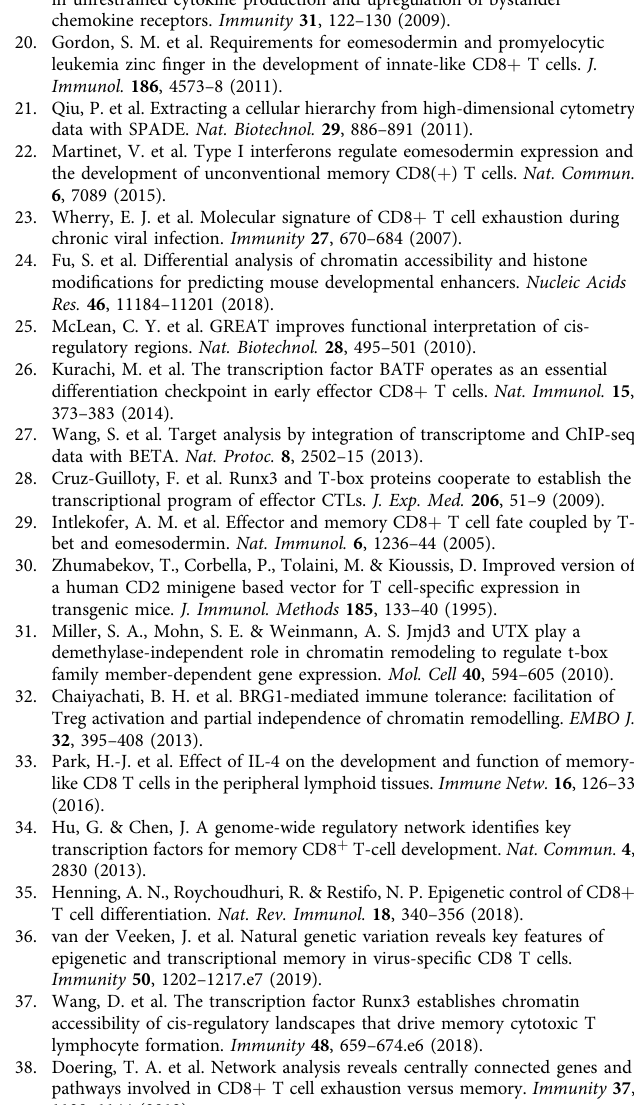
Fig. 7 BRG1 is critical to induce EOMES-dependent program. a Immunoblot (IB) of lysates from 293 cells transfected with an Eomes vector and immunoprecipitated (IP) with an anti-EOMES (up) or anti-BRG1 (down) antibody. b ChIP experiment for EOMES and BRG1 from WT and Eomes Tg CD3 + CD8SP thymocytes followed by qPCR at the indicated loci. Each horizontal bar represents an individual data point from a single experiment. c Representative fl ow cytometry plots gated on CD3 + CD8SP thymocytes from mice lacking Smarca4 expression in T cells ( Smarca4 fl / fl xCD4Cre : Smarca4 Δ T , down) and their littermate controls ( Smarca4 fl / fl , up) after 4 days of daily intra-peritoneal injection of anti-IL-4/rIL-4 (IL-4c) or an isotype control (left panel). Percentage of EOMES hi CD3 + CD8SP thymocytes after isotype control or IL-4c injections (right panel). d Mixed bone marrow chimera experimental scheme (upper panel). cGy centigrays. Percentages of EOMES hi cells among WT vs. Smarca4 Δ T CD3 + CD8SP thymocytes (lower left panel), and proportions of WT vs. Smarca4 Δ T cells among CD3 + CD8SP thymocytes (lower right panel) after isotype control or IL-4c injections. e Expression (MFI) of cell markers in EOMES lo and EOMES hi CD3 + CD8SP thymocytes from Smarca4 fl / fl vs. Smarca4 Δ T mice after IL-4c injections. f Representative correlation plots of EOMES and CXCR3 single-cell (sc) fl uorescences in CD3 + CD8SP thymocytes from Smarca4 fl / fl and Smarca4 Δ T mice after IL-4c injections. Kendall ’ s Tau correlation coef fi cients and Loess fi tting curves (red lines) and their corresponding con fi dence interval (gray area) are shown. g Representative fl ow cytometry plots gated on CD8 + splenocytes from Smarca4 fl / fl and Smarca4 Δ T mice at steady-state, showing the proportions of CD44 hi CD49d lo (virtual memory cells, VM) and CD44 hi CD49d hi (true memory cells, TM) (left panel). VM proportions in CD8 + splenocytes from Smarca4 Δ T and Smarca4 fl / fl mice after isotype control or IL-4c injections are shown (right panel). h Expression (MFI) of cell markers in naïve (N), TM, and VM subpopulations of CD8 + splenocytes from Smarca4 fl / fl and Smarca4 Δ T mice. In c , d , e , g , and h , horizontal bars indicate median± interquartile range (each point represents a single mouse, n = 5 mice per group). Statistics were calculated using Mann – Whitney test. ns not signi fi cant, * P < 0.05, ** P < 0.01. Source data are provided as a Source Data fi le.Source Data fi